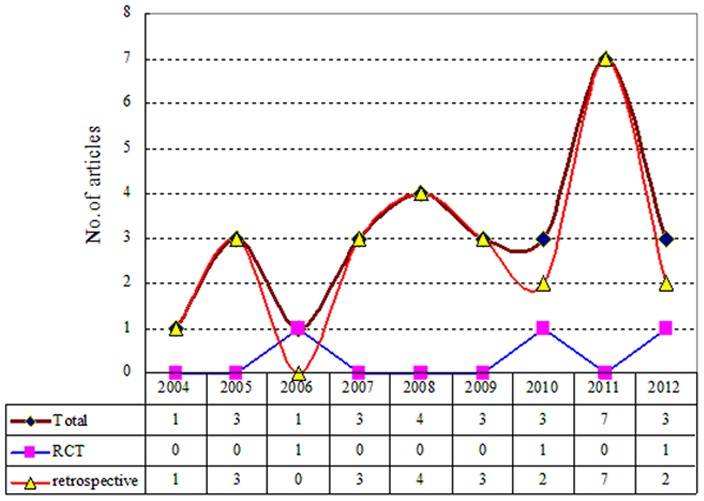
Bibliometric map of included studies.